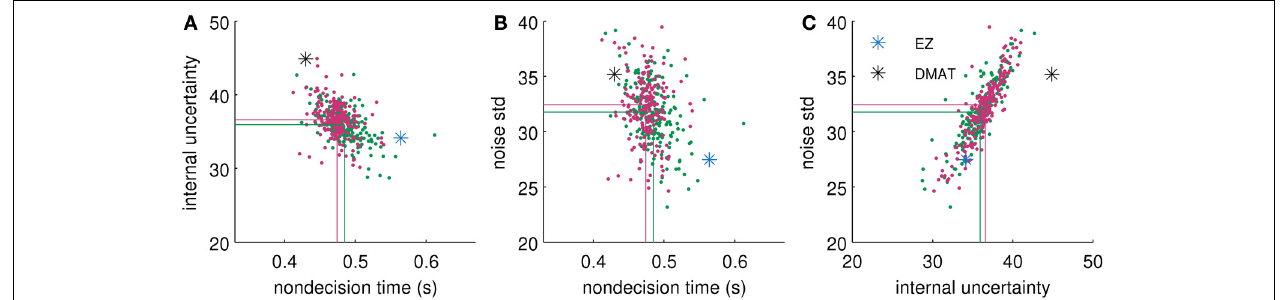
FIGURE 6 | Comparison of approximate posterior distributions for different parameter priors. We show two-dimensional scatterplots of samples for each possible pair of parameters [ (A) non-decision time T nd vs. internal uncertainty ˆ σ , (B) T nd vs. noise standard deviation σ , and (C) ˆ σ vs. σ ]. Green dots show samples from posterior with priors reported in Equation (45). Red dots show samples from posterior with double as wide priors. Lines visualize the corresponding means over samples. For